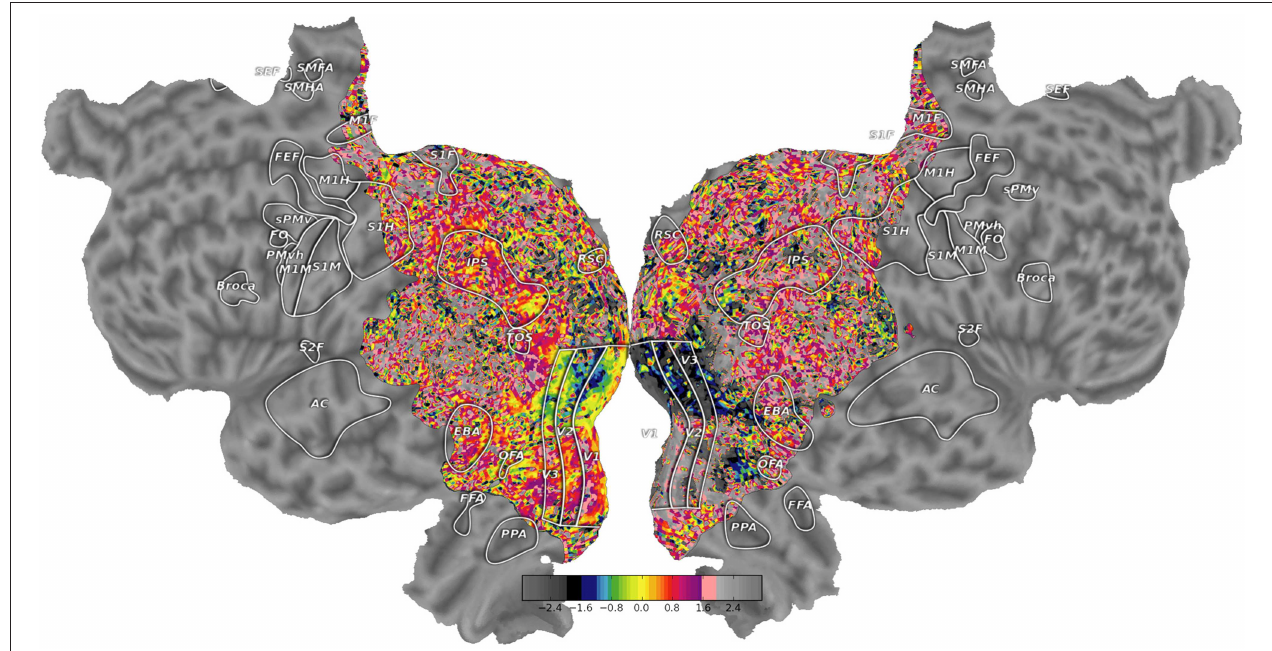
FIGURE 6 | High quality flatmaps generated by pycortex. Cortical flatmaps can be quickly generated in pycortex using the quickflat module. Matplotlib is used to view figure-quality flatmaps in a standard size. Options are available to include a colorbar, ROI outlines, ROI labels, and curvature information. This figure shows retinotopic organization of visual cortex for one subject as in Hansen et al.